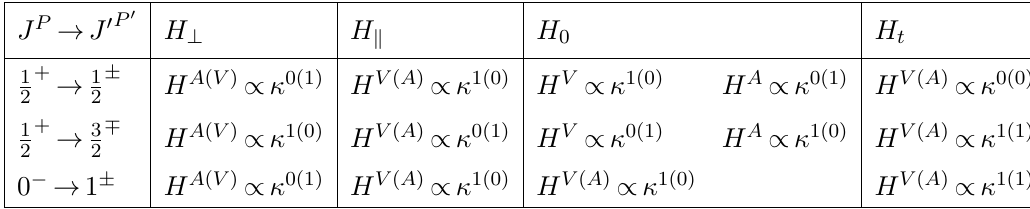
Table 1 . Leading κ -dependance in J P → J 0 P where C corresponds to H V ( A ) for 0 − → 1 − which was the main focus of that paper. Changing ± the parity of the initial state demands V ↔ A in the table above. HAs which are not given, such as , do vanish by parity in QCD. The HA H H A | − 1 2+ → 1 ⊥ 2 vector and axial ones contributes to the same power. The T ( T the ones for V ( A )